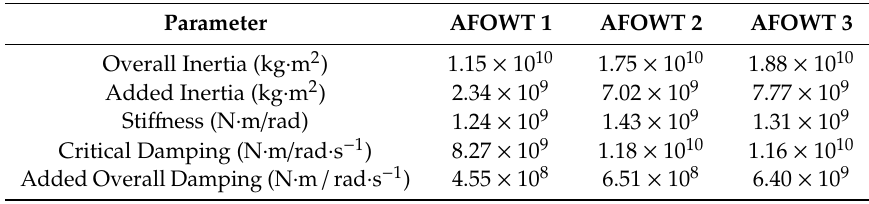
Table 5. Dynamic parameters of the